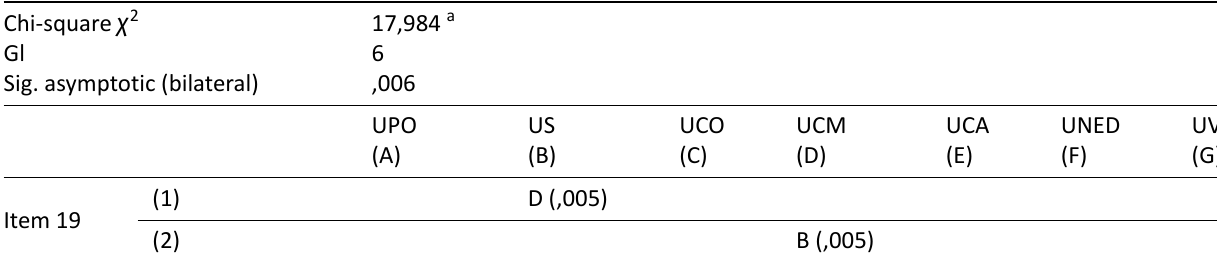
Table 8. Chi‐square and comparisons of proportions (item